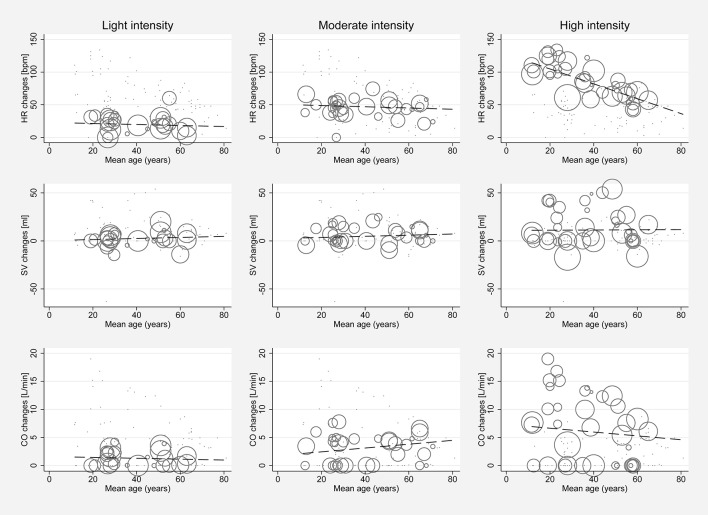
Univariate meta-regression analyses investigating age dependency of absolute mean changes of HR, SV, and CO in healthy subjects for all stress intensities. First row: age dependency of HR changes for light intensity (coefficient −0.078, p = 0.685, adjusted R2 = 0%), moderate intensity (coefficient −0.095, p = 0.534, adjusted R2 = 0%) and high intensity (coefficient −1.139, p < 0.001, adjusted R2 = 72.14%). Second row: Age dependency of SV changes for light intensity (coefficient 0.055, p = 0.767, adjusted R2 = 0%), moderate intensity (coefficient 0.059, p = 0.68, adjusted R2 = 0%) and high intensity (coefficient 0.01, p = 0.964, adjusted R2 = −7.81%). Third row: Age dependency of CO changes for light intensity (coefficient −0.007, p = 0.967, adjusted R2 = 0%), moderate intensity (coefficient 0.034, p = 0.813, adjusted R2 = 0%), and high intensity (coefficient −0.034, p = 0.849, adjusted R2 = 0%). Bubble size indicates study sample size.